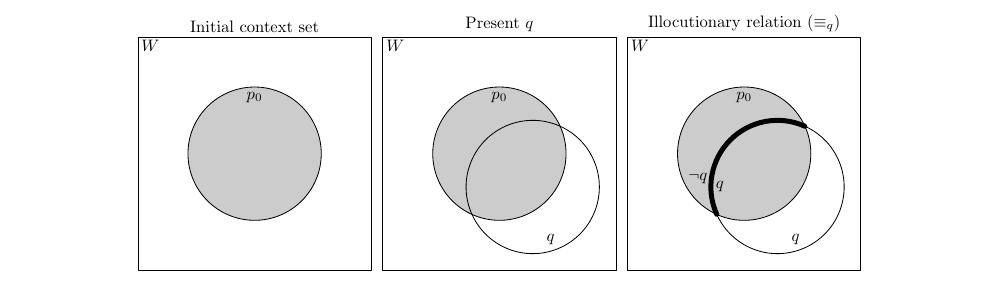
Figure 2 Updates for ( 12 ) and ( 13 ): polar interrogative mood The first diagram in Figure 2 represents the initial context set. In the second diagram, a discourse referent is introduced for the at-issue proposition q .